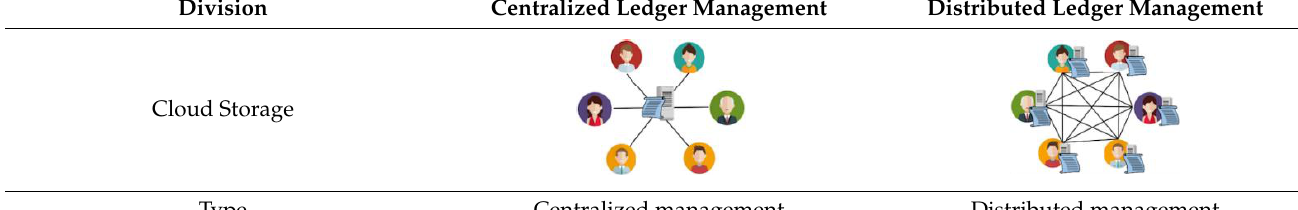
Table 1. Comparison of centralized ledger management technology with a distributed ledger management structure. Division